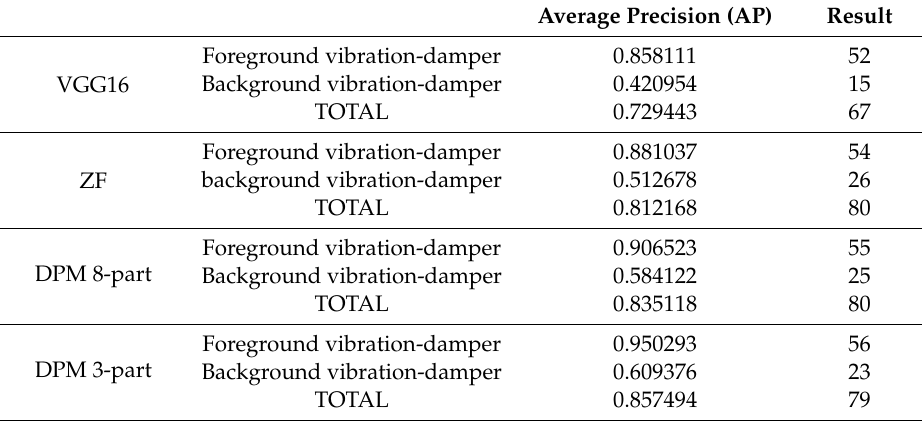
Table 1. Detection results for real images using the virtual dataset as the training sample.